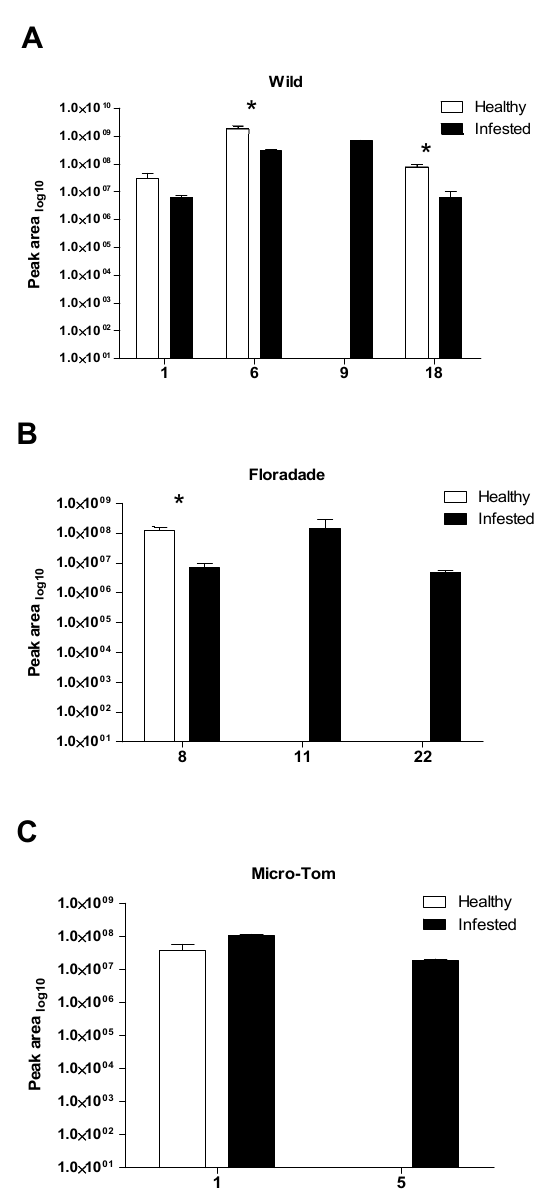
Figure 4. Volatile organic compounds detected in Solanum lycopersicum varieties (wild, Floradade and Micro-Tom) from healthy (white bars) and infested (black bars) plants. ( A ) Wild plants with compounds: α -pinene (1), ( + )-4-carene (6), β -phellandrene (9), and caryophyllene (18). ( B ) Floradade plants with compounds: ( + )-2-carene (8), ( + )-sabinene (11), and phenol, 2,6-bis(1,1-dimethylethyl)-4-(1-methylpropyl) (22). ( C )Micro-Tom plants with compounds: α -pinene (1), and β -pinene (5). VOC profiles were obtained from the three varieties for a single bioassay in healthy plants (psyllid-free) and two bioassays in infested tomato plants. Values are means ( ± SE; healthy n = 3; infested n = 6). Level of significance: *, P < 0.05. (Univariate ANOVA, non-parametric Kruskal-Wallis test at P = < 0.05).